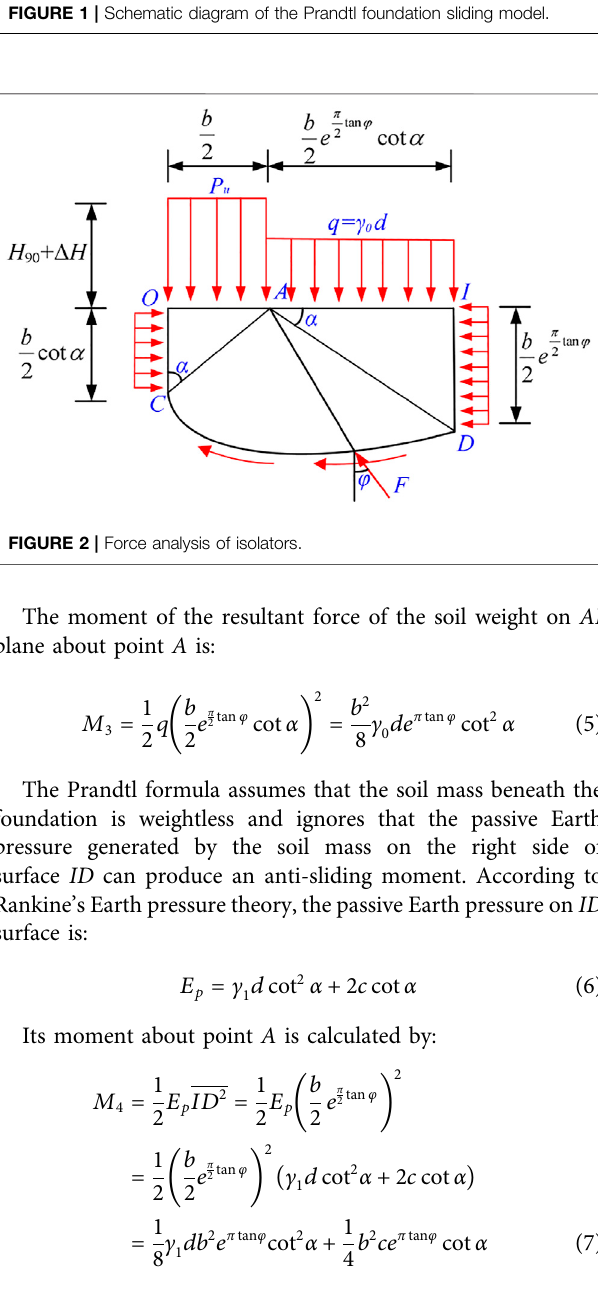
FIGURE 1 | Schematic diagram of the Prandtl foundation sliding model.